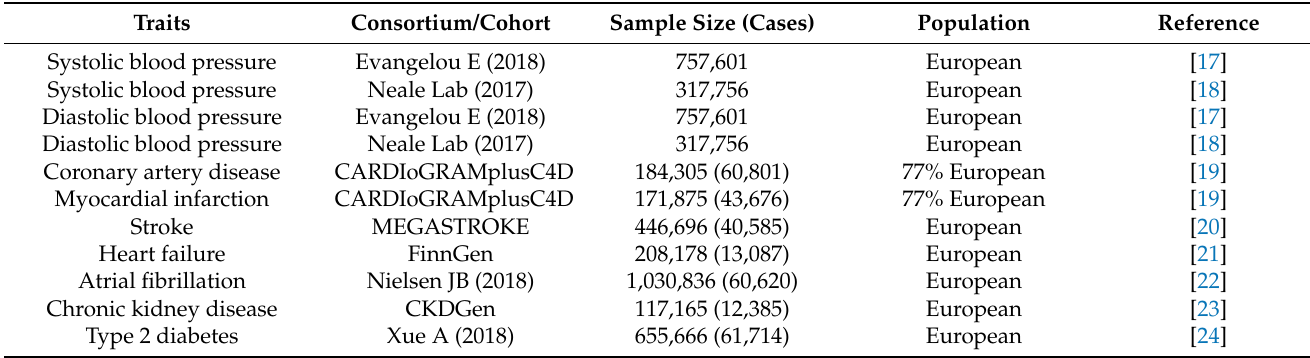
Table 1. Genome-wide association studies included in this MR